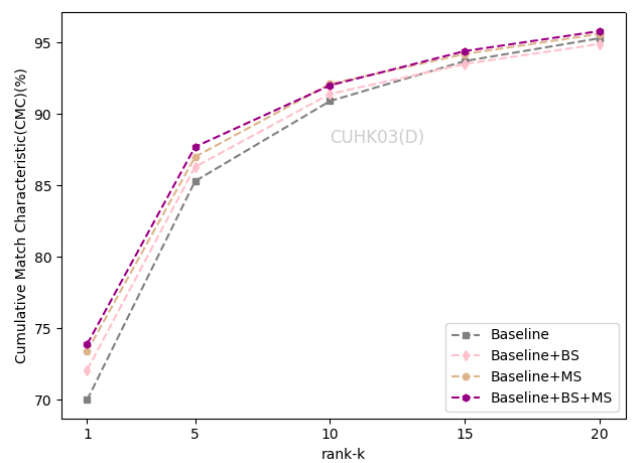
Figure 7. The CMC curve on CUHK03(L).